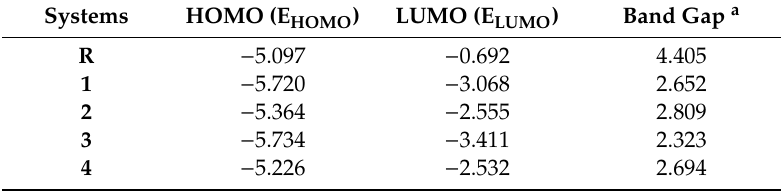
Table 1. The E HOMO , E LUMO and energy band gap (E LUMO − E HOMO ) of the studied compounds R and 1 – 6 . Systems HOMO (E HOMO ) LUMO (E LUMO ) Band Gap